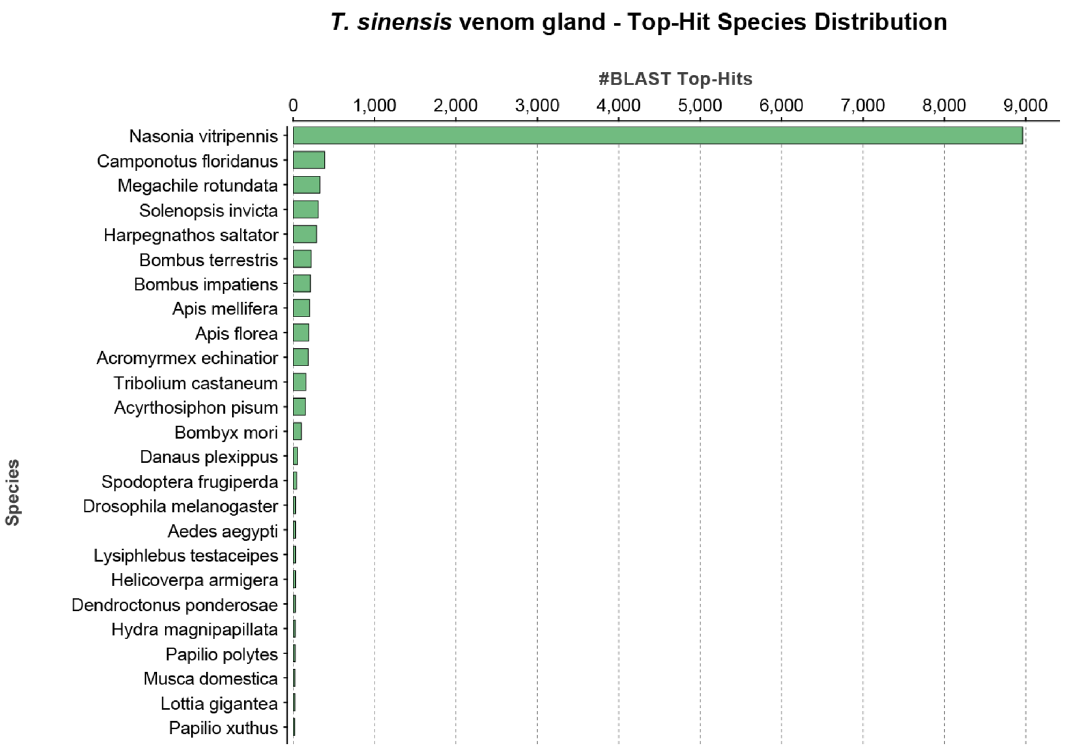
Figure 2. Distribution of top BLAST hit species for the T. sinensis transcriptome assembly. Top BLAST hits were obtained from BLASTx analysis against the NCBI non-redundant (nr) protein database. The number of top BLAST hits per species is shown on the x-axis. The highest number of matches were obtained for the ectoparasitoid wasp Nasonia vitripennis